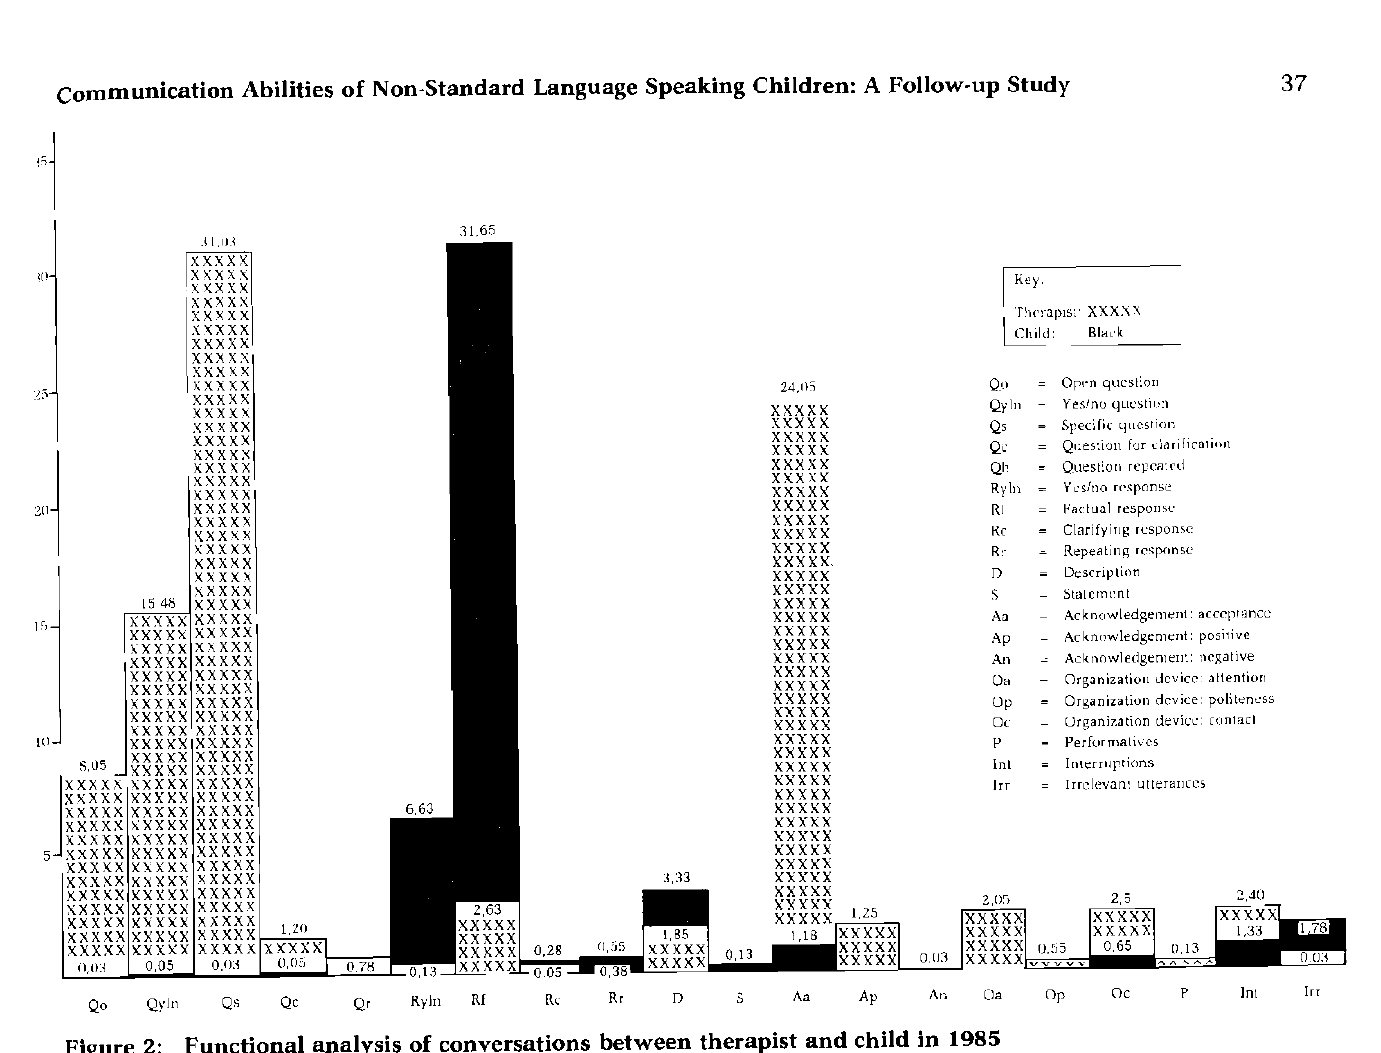
Figure 2: Functional analysis of conversations between therapist and child in 1985 These figures indicate that there are no great differences between the therapist's and children's utterances for the two testing situations. Table 3 reflects significant differen- ces between the means on the different categories for the therapist's as well as the children's utterances.